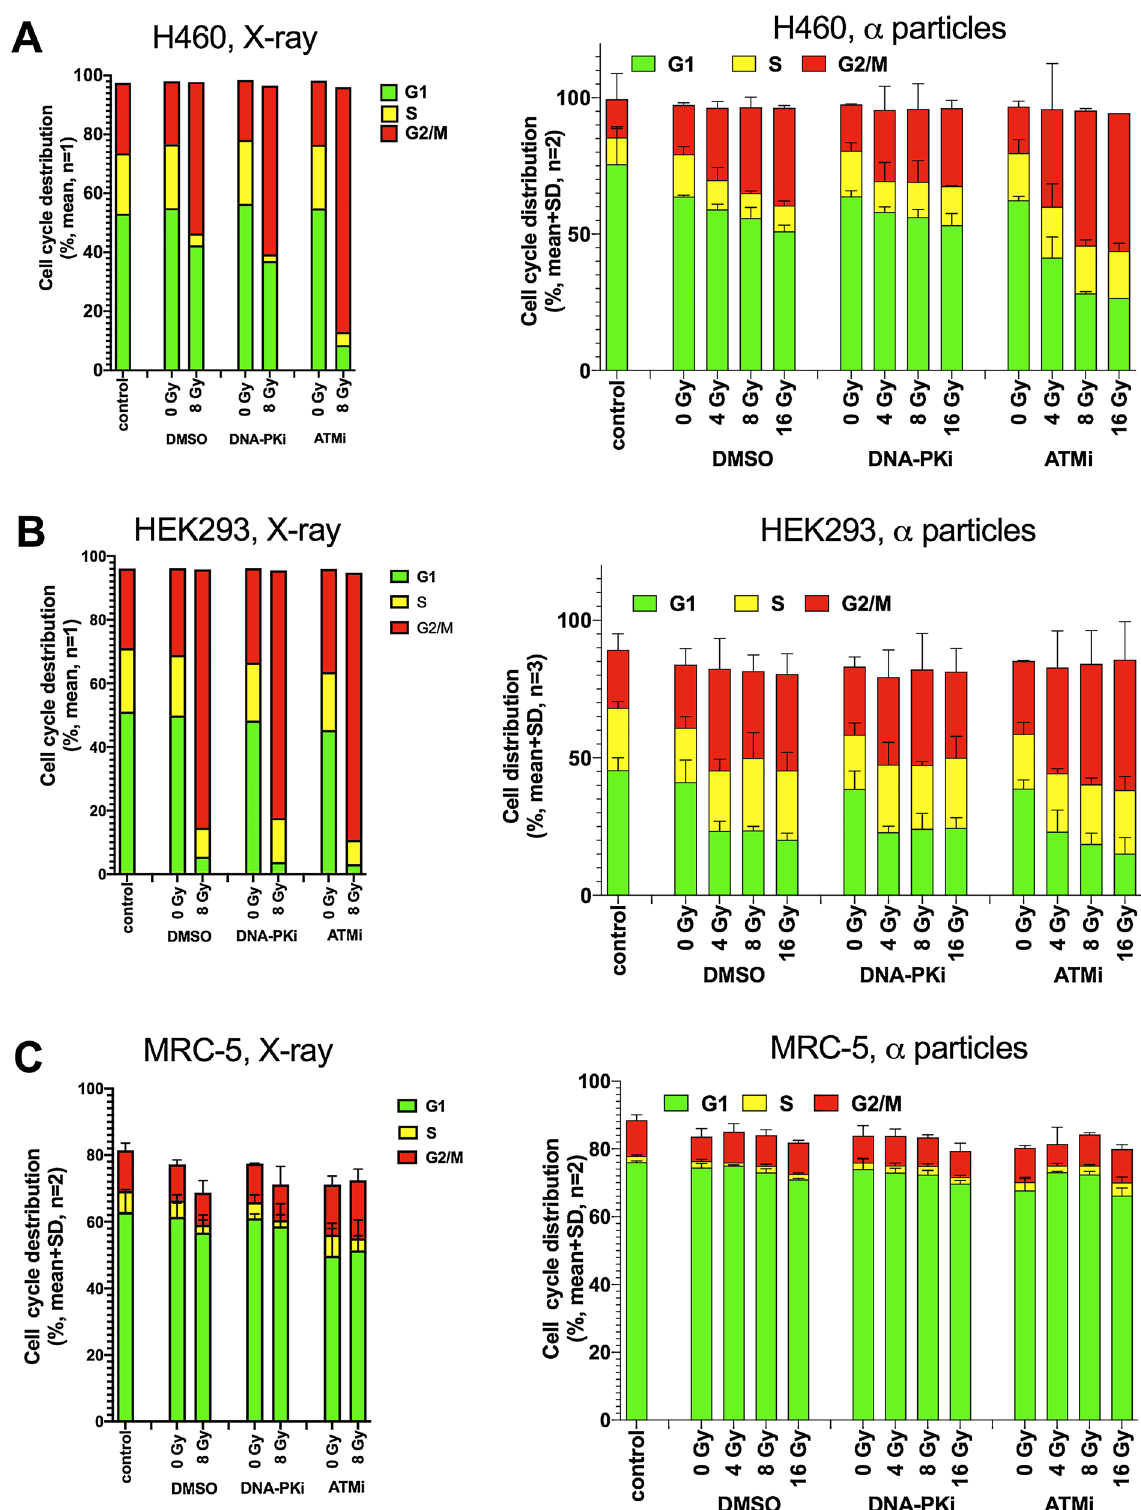
Figure 6. DDR inhibitors selectively affect cell cycle arrest in G 2 /M after X-ray and alpha radiation in various cell lines. Cell cycle distributions for H460 ( A ), HEK293 ( B ) and MRC-5 ( C ) cells after treatment with 200 nM DNA-PKi M3814 and ATMi ADZ-1390 for 2 h prior to X-ray exposure or alpha